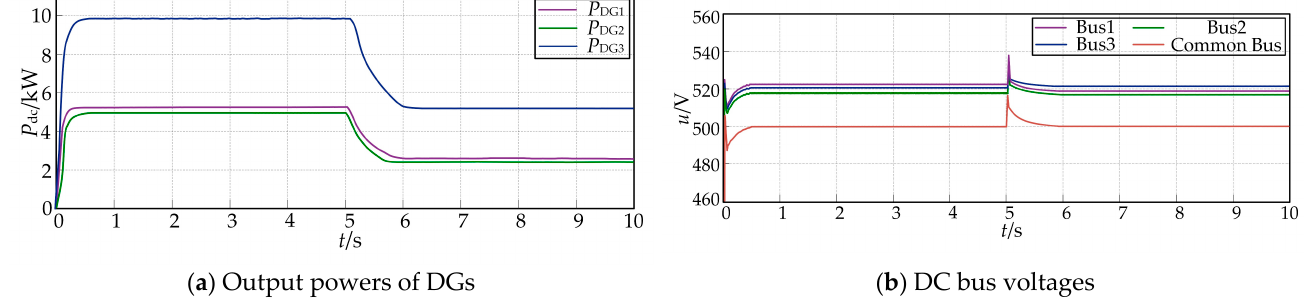
Figure 16. Simulation results of example 1 under the proposed control strategy in [8].